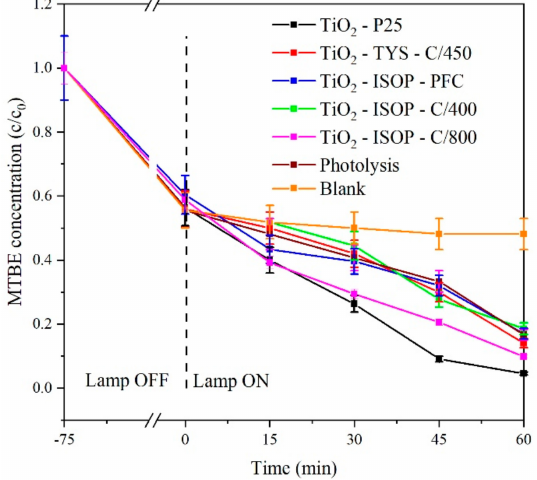
Figure5. ThedependenceofMTBE(methyl tert -butylether)concentrationontimeoverTiO 2